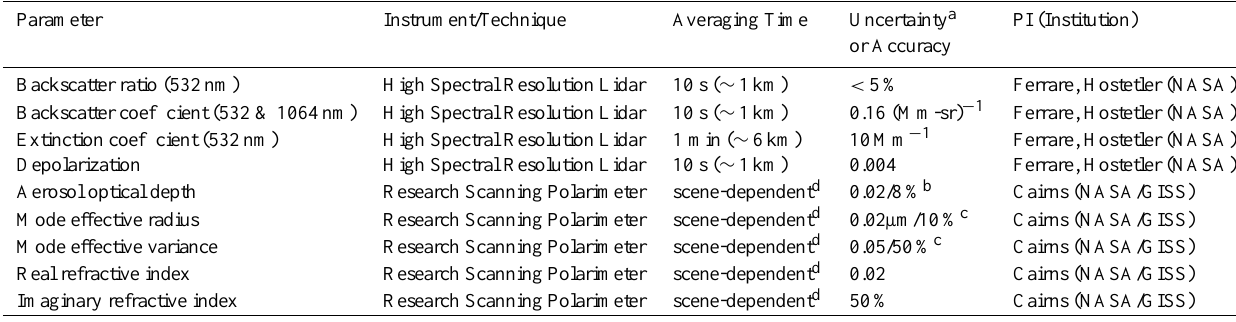
Table 3. Measurements and Instruments aboard the NASA B-200 King Air Aircraft during CARES 2010. Parameter Instrument/Technique Averaging